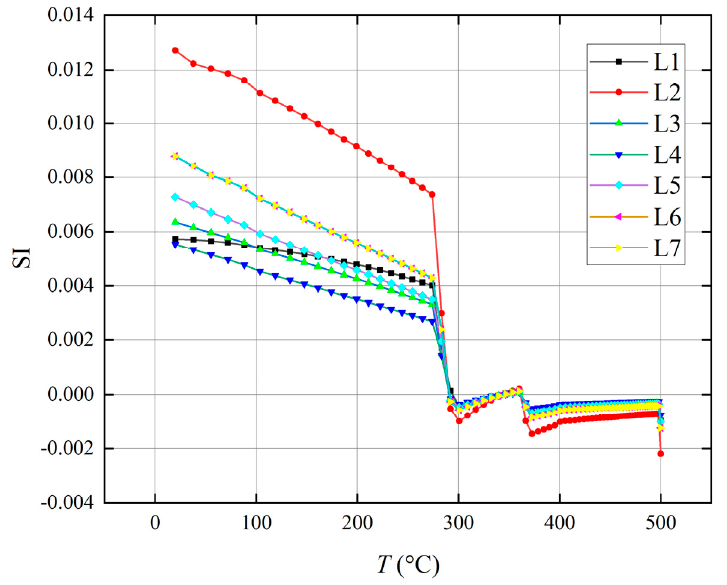
Figure 6. Variation rule of sensitivity coefficient of circumferential ribs with temperature (L73).